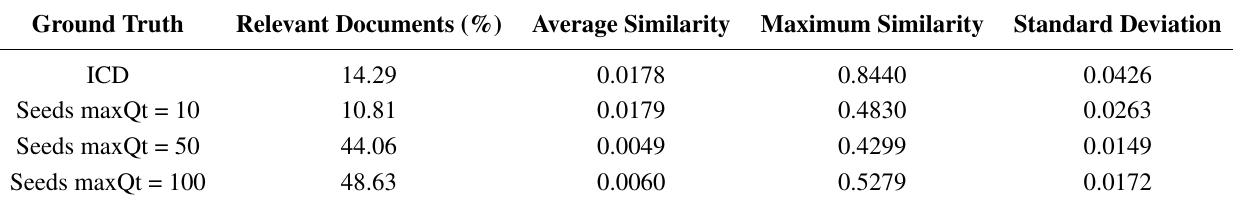
Table 4. Statistics on ARCOMEM Crawl.